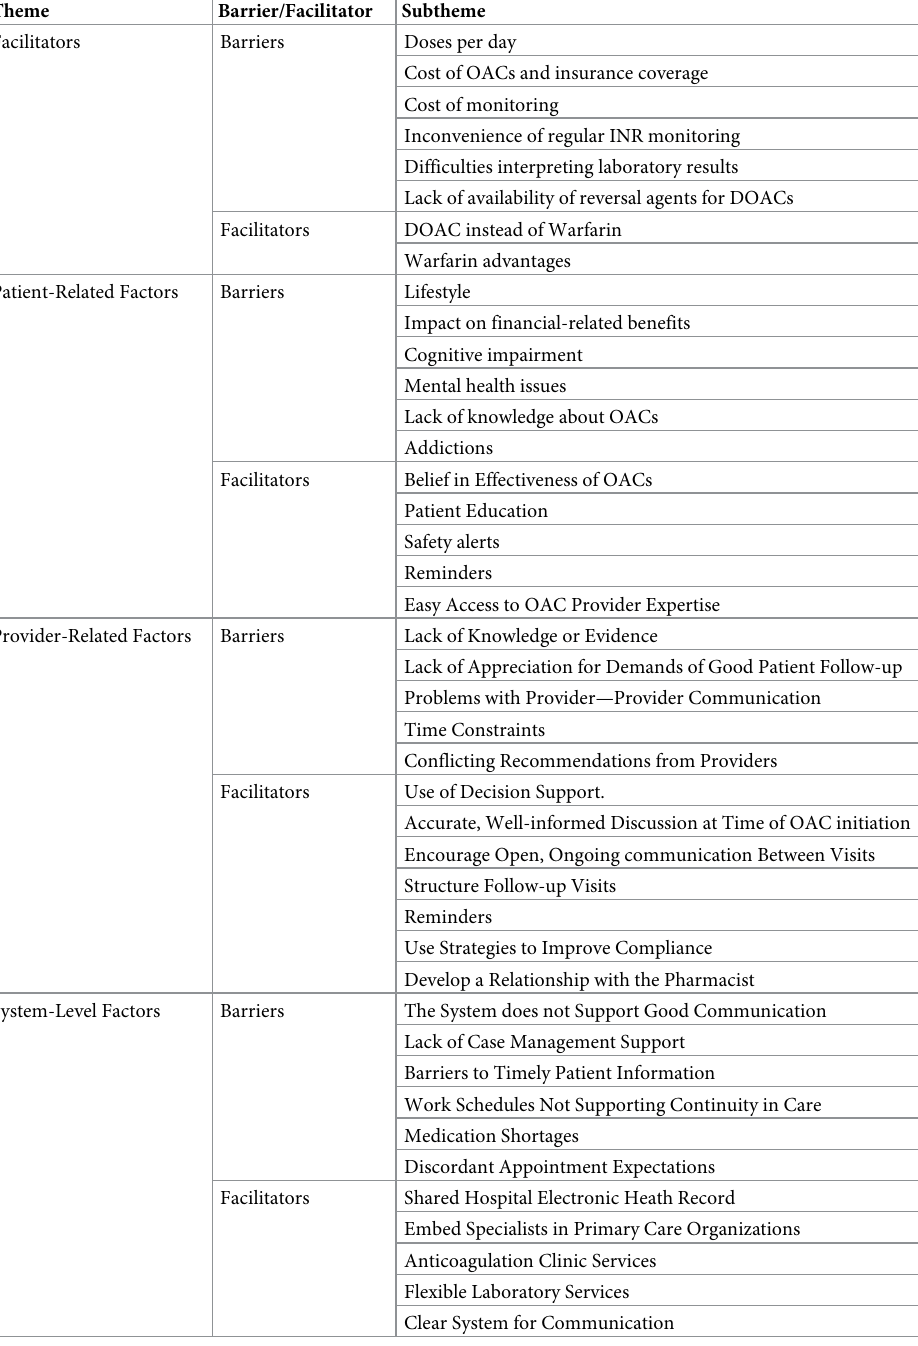
Table 2. Results themes and